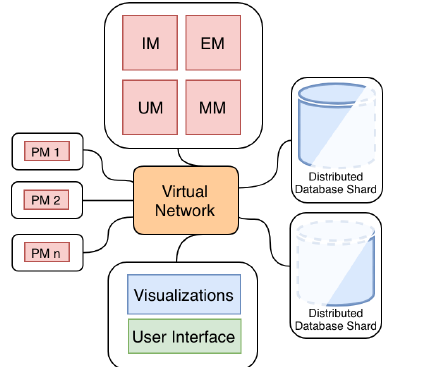
Figure 4. Deployment